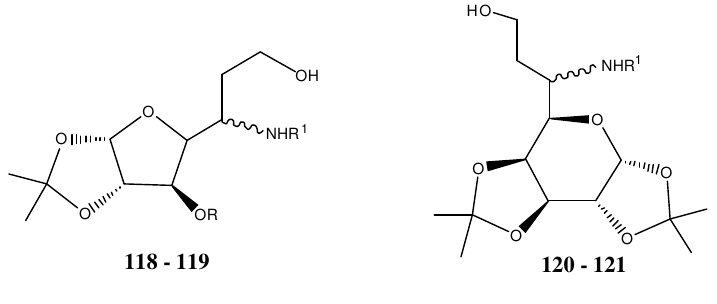
FIGURE 11. Structures of glycosylated amino alcohols 118–121